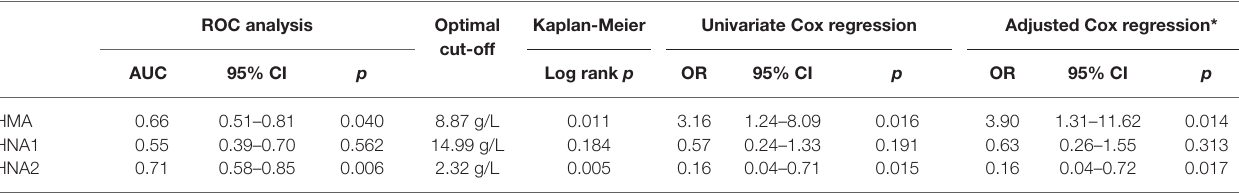
TABLE 4 | Regression analyses for day-7 albumin forms and 90-day